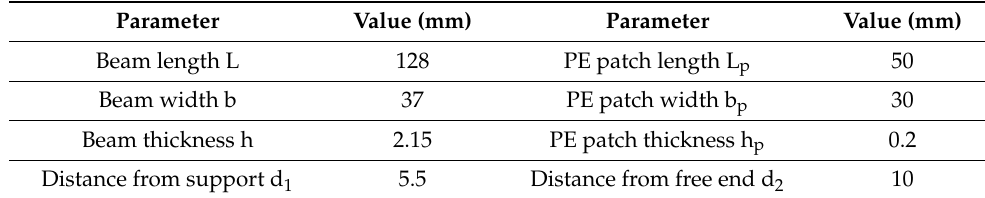
Figure 2. Composite beam with PE patch: FE mesh and geometric parameters. Table 1. Beam and PE patch geometric